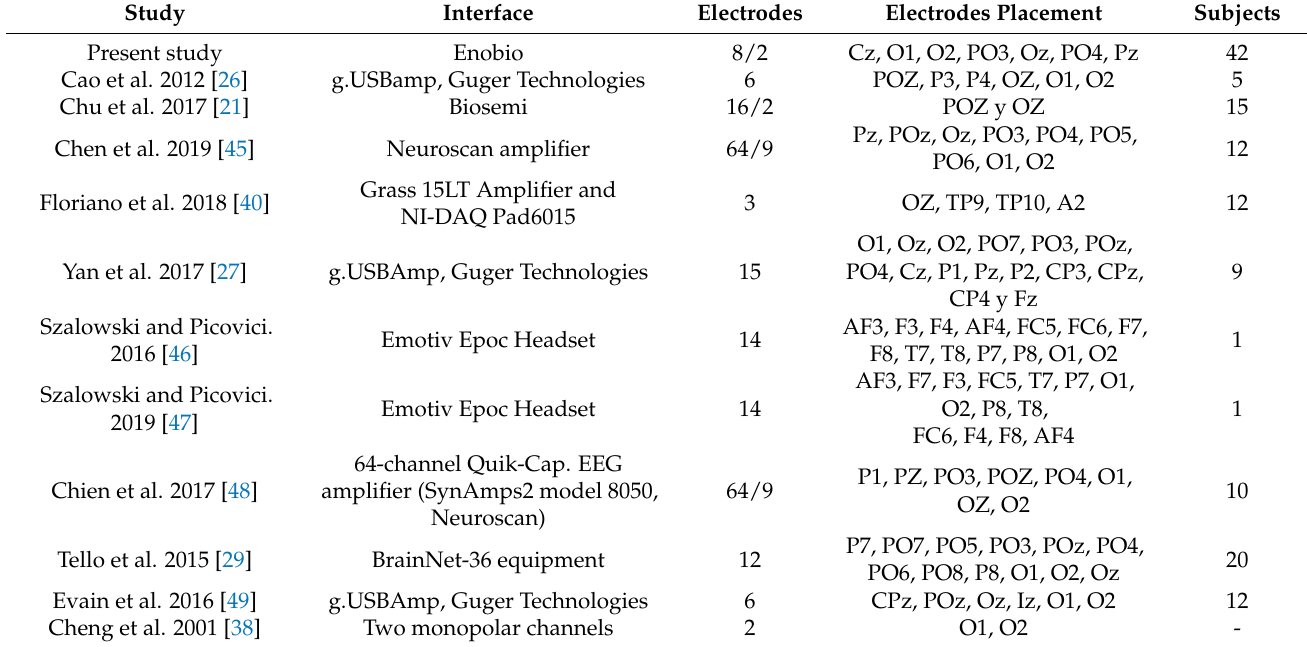
Table 8. Characteristics of adquisition device and